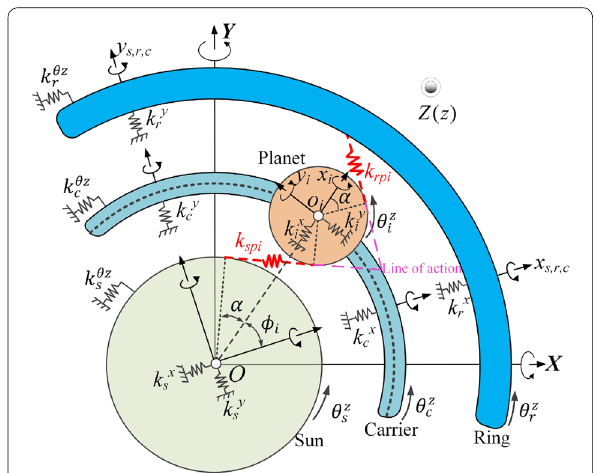
Figure 4 Lumped parameter model of planetary gear stage